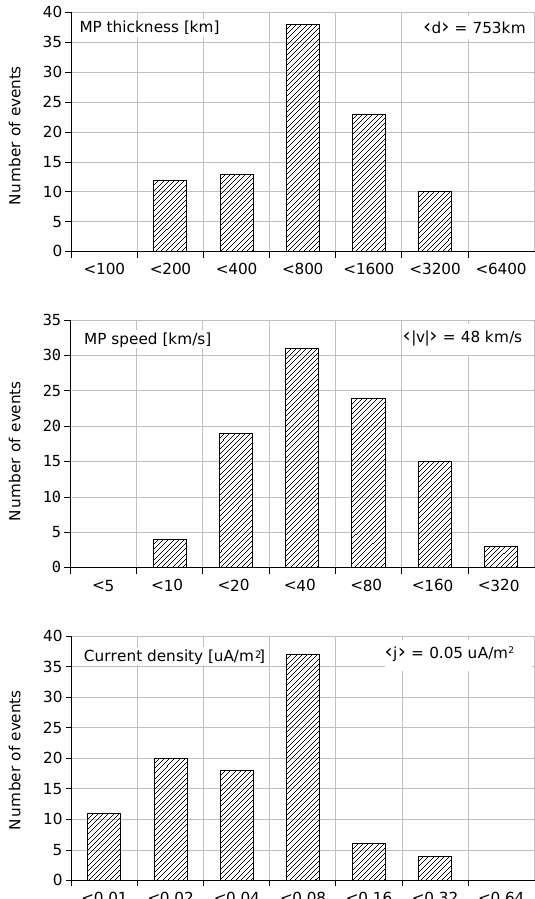
Table 1. Magnetopause thicknesses for 96 crossings.